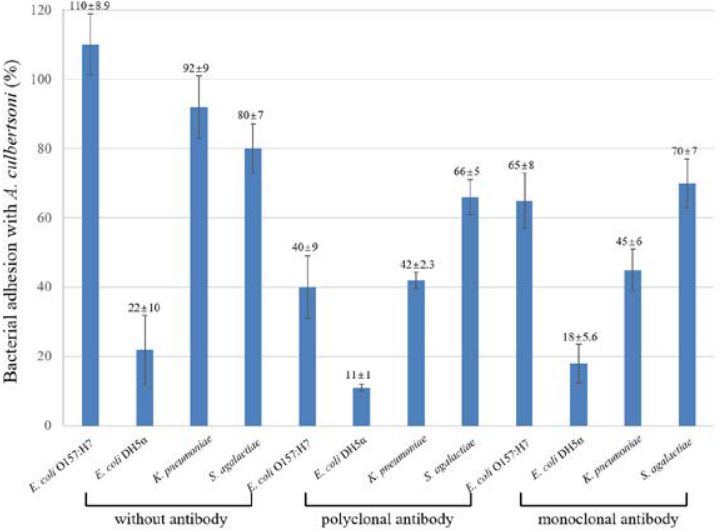
Fig. 1. Percentage of bacterial association with A. culbertsoni trophozoites . Pathogenic E. coli O157:H7, K. pnuemoniae, S. agalactiae and one non-pathogenic E. coli DH5 a were analyzed by association, and antibodies to MBP was preincubated with the amoeba for 30 min prior to the association assay. This experiment was performed in triplicate wells with three times, and data were described by mean ± standard deviation (SD)